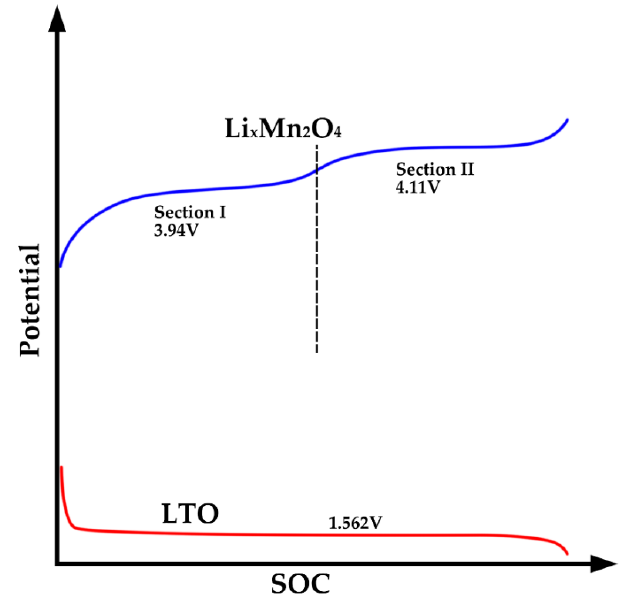
Figure 5. Schematics of potential of LTO and LMO material.